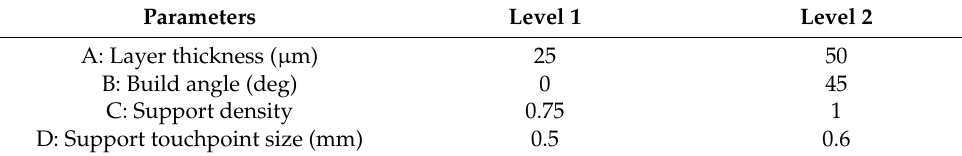
Table 2. Parameters and control levels.